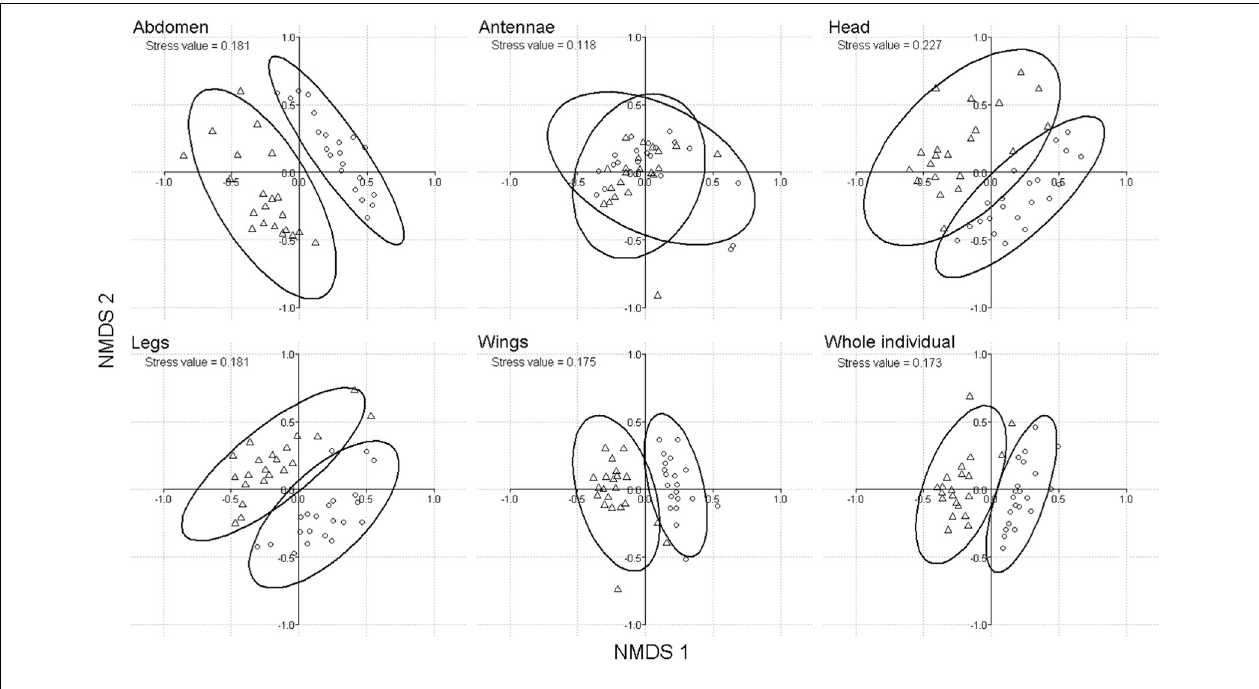
FIGURE 1 | Discrimination of B. anynana sexes based on cuticular lipid composition (including the three MSP components) of abdomen, antennae, head, legs, wings and whole individuals,